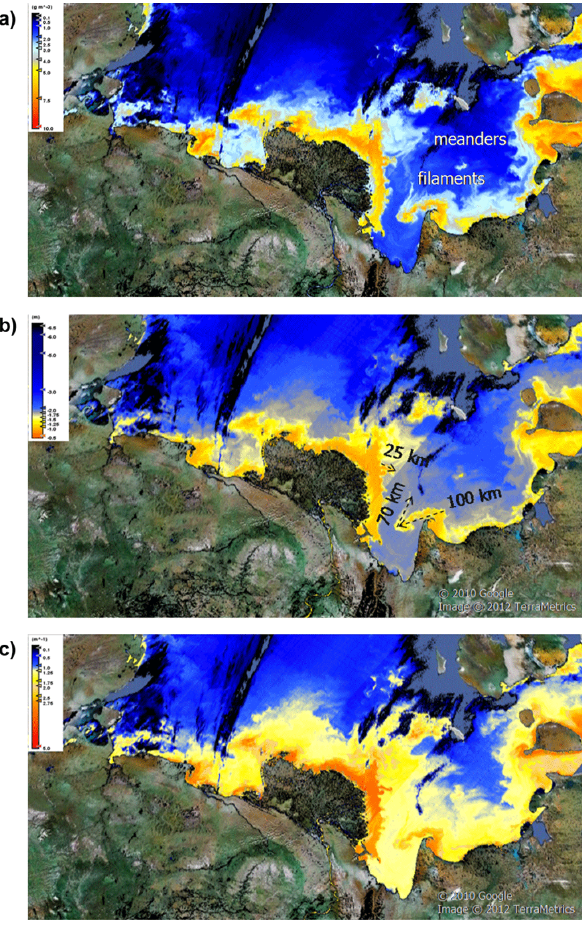
Figure 8. MERIS colour-coded maps of the southern Laptev Sea, on 25 September 2009 at 11:55 (local time) visualize the fields of me- anders and filaments. The mapped C2R parameters are (a) MERIS C2R_TSM (gm − 3 ) , (b) MERIS C2R_Z90 (m), and (c) MERIS C2R_absorption (m − 1 )